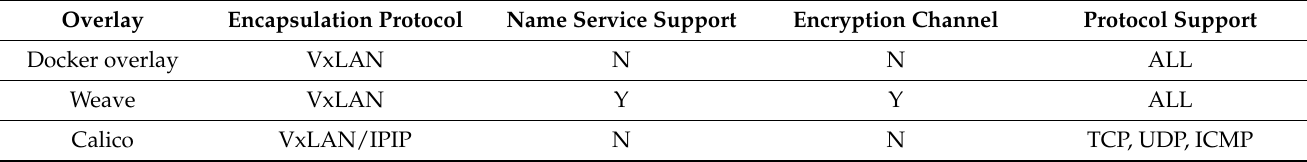
Table 2. Characteristics of virtual networking solutions